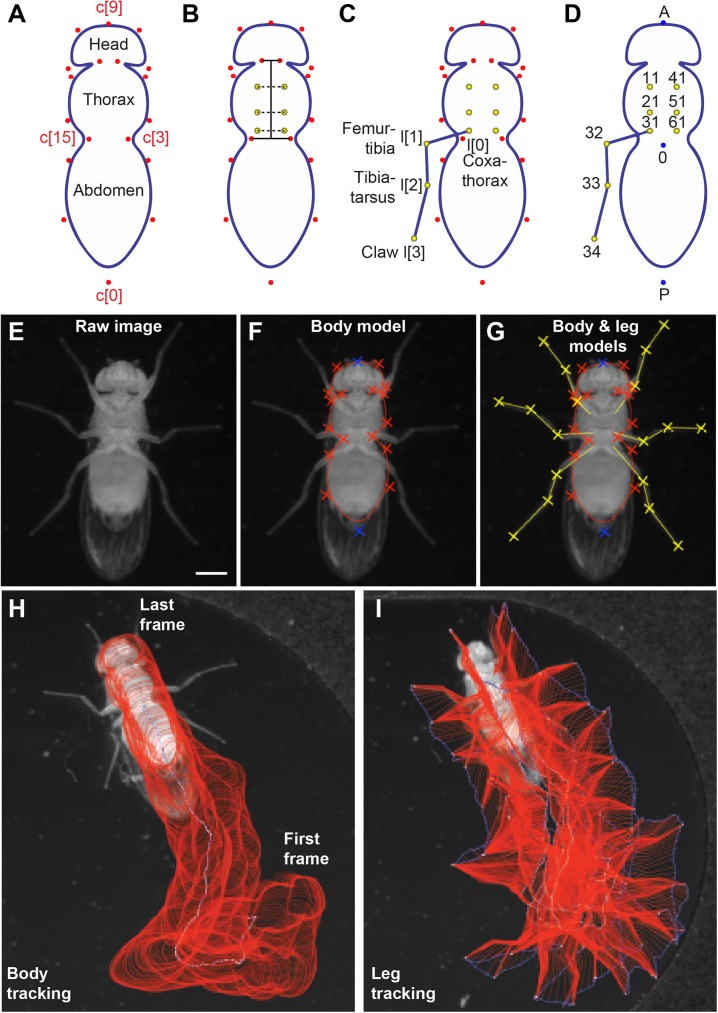
FlyLimbTracker uses active contour models to annotate the Drosophila body and legs.(A) The body model is a closed snake consisting of 18 control points (c[0] to c[17]). Control points c[0] and c[9] correspond, respectively, to the posterior-most position on the abdomen and the anterior-most position on the head. All other control points are symmetric along the anteroposterior axis of the body (e.g., control points c[3] and c[15]). (B) Six leg anchor positions (yellow) between the coxa and thorax are defined empirically based on a linear combination of distances from the head-thorax boundary, the thorax-abdomen boundary, and a distance from the thoracic midline. These positions are then shifted depending on how the body model is optimally deformed to fit the contours of a specific animal. (C) The leg model consists of four control points including a thorax-coxa attachment l[0], the femur-tibia joint l[1], the tibia-tarsus joint l[2], and the pretarsus/claw l[3]. For simplicity, control points for only a single leg are shown. (D) In sum, 27 positions are calculated for each fly per frame: a centroid (0), anterior point (A), posterior point (P), as well as the body anchor, first intermediate, second intermediate and tip for each of the six legs. Our data labeling convention is as follows. Right and left legs are numbered 1 to 3 (front to rear) and 4 to 6 (front to rear), respectively. Each leg has four control points labeled 1 to 4 in the units digit that correspond the body anchor (1), leg joints (2 and 3), and claw (4). In each label, the leg number is shown in the tenths digit and the control point in the units digit. For example, the label “11” refers to the body anchor of the right prothoracic leg 1. For simplicity, only the control points for leg 3 are shown. (E) An example raw image of the ventral surface of a fly used for segmentation. (F) This image is first segmented using the parametric body snake consisting of 18 control points (red and blue crosses). (G) Subsequently, leg segmentation is initialized through automatic tracing from body anchor points to user-defined leg tips. From this initialization, an annotation is performed using open snakes consisting of four control points (yellow crosses). (H) Body and (I) leg segment tracking annotation for flies during a 455-frame (1.93 s) sequence. Annotation results (red) and the centroid in H or leg tip positions in I (blue) for each frame are overlaid.